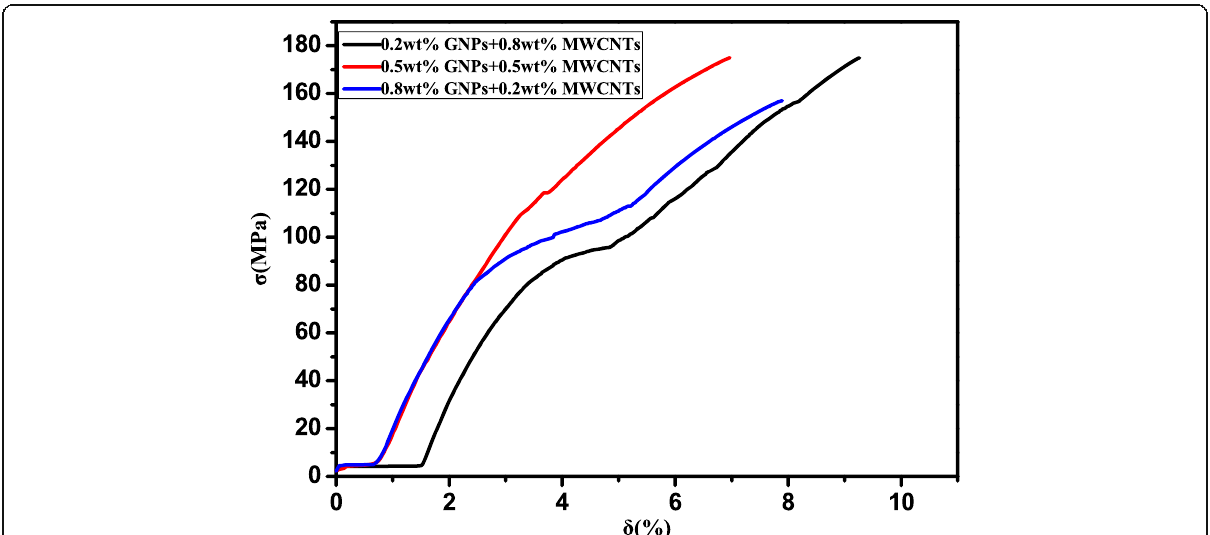
Fig. 9 Tensile deformation curves of sintered nanocomposites: Nanocomposites with 0.8 wt% graphenes and 0.2 wt% MWCNTs, nanocomposites with 0.5 wt% graphenes and 0.5 wt% MWCNTs, and nanocomposites with 0.2 wt% graphenes and 0.8 wt%